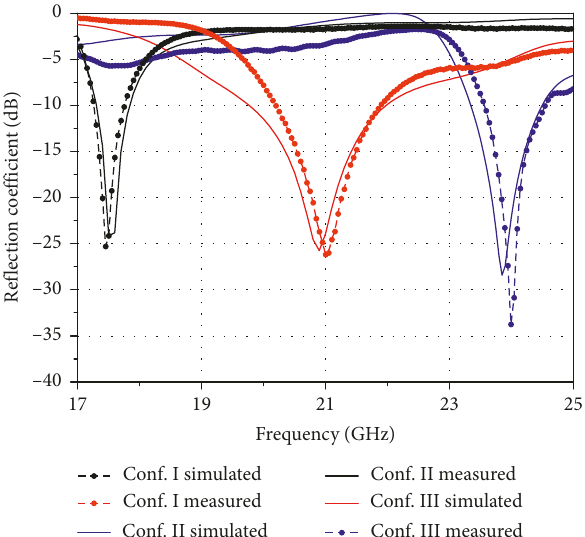
Figure 9: Millimeter-wave horn filtenna reflection coefficient. Conf. I ( d ( d 1 � 0.85mm and d 2 � 1.8mm) centered at 21GHz; Conf. III ( d 1 � 0.5mm and d 2 � 1mm) centered at 24